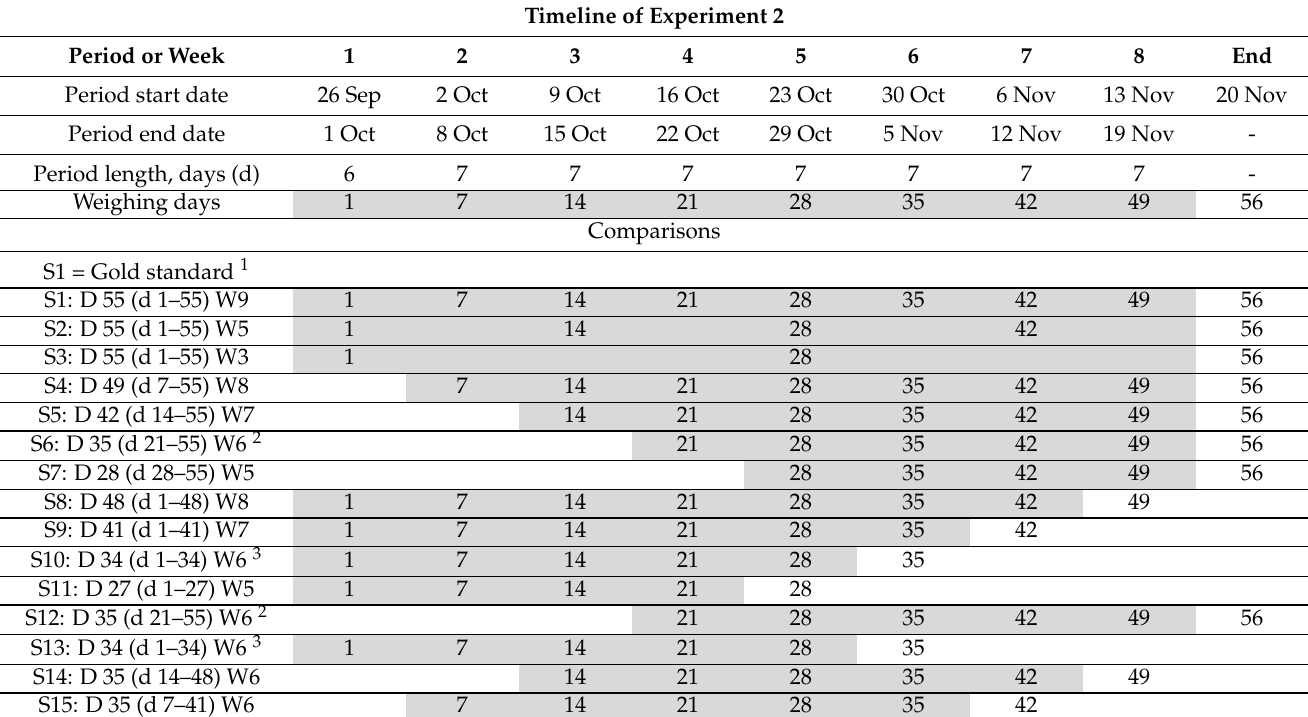
Table 2. Timeline and comparisons of the standards (or data subsets) (S1–15) of experiment 2 with dairy breed bulls (55 Holstein and 55 Nordic Red dairy bulls). Standards S1–15 varied in terms of the duration of test periods (d) and the number of times the animals were weighed (W). Note that in the description of the standards, D refers to the total duration of the test period for standards S1–15 and d refers to the order of the days in S1. Start day of the experiment (d 1) was the day when feed intake measurements were initiated. The grey shading indicates the periods from which the daily dry matter intake data were used. The numbers in the cells of each data subset indicate the weighing days for that test